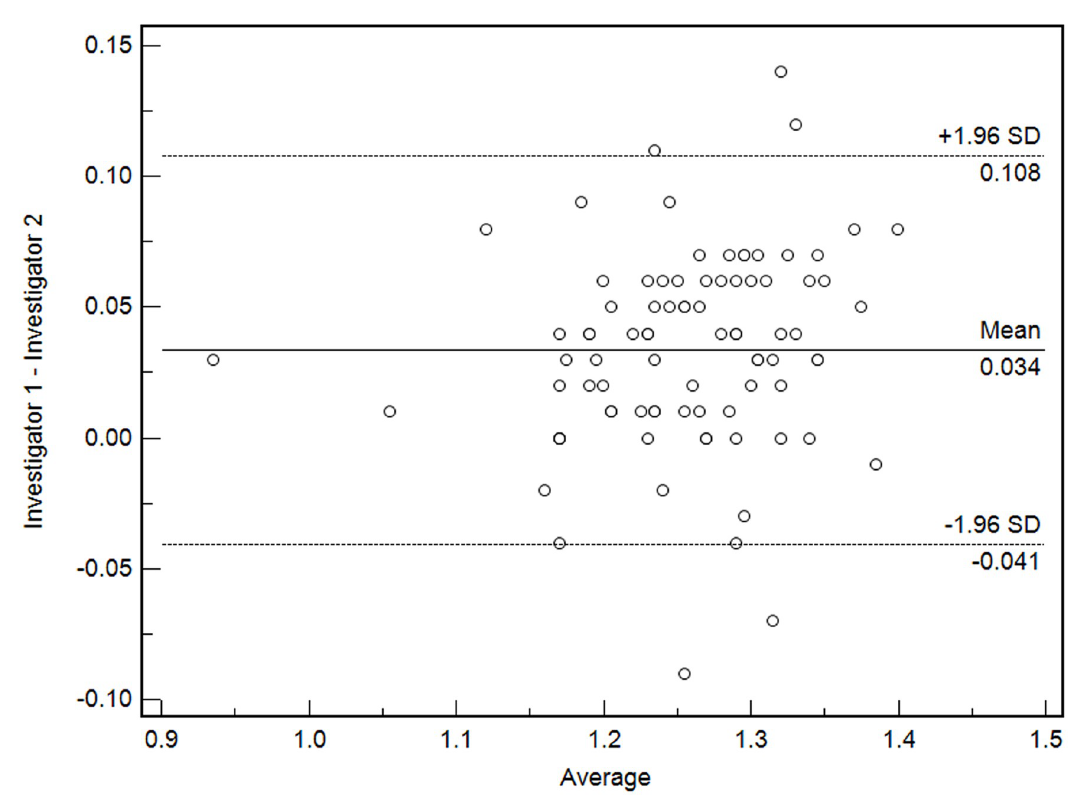
Fig 3. Bland-altman plots of interclass correlation coefficients between